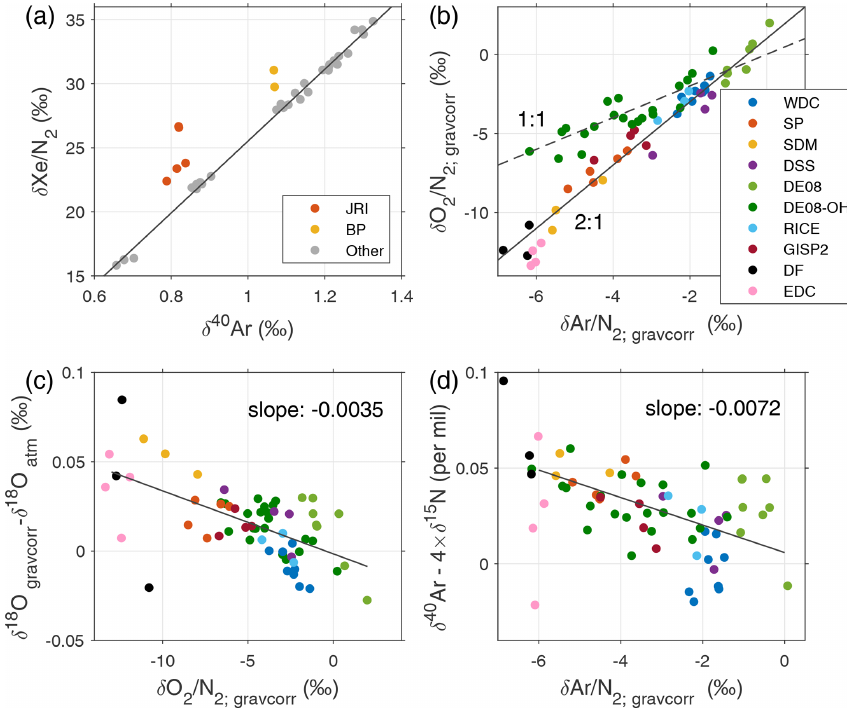
Figure A1. Elemental ratios in the 11-site calibration study of late Holocene samples. (a) δ Xe / N 2 vs. δ 40 Ar in all ice core samples. δ 40 Ar is used solely to illustrate gravitational enrichment, and a similar picture arises when plotted against any isotopic pair. Refrozen meltwater (elevated δ Xe / N 2 ) was seen in all samples from the Antarctic Peninsula (James Ross Island and Bruce Plateau sites), despite selecting samples free of visible melt features. (b) The relationship between the commonly used gas loss proxies δ O 2 / N 2 and δ Ar / N 2 corrected for gravity. (c) Enrichment in δ 18 O (corrected for gravity and atmospheric δ 18 O atm ) plotted against gravity-corrected δ O 2 / N 2 . (d) δ 40 Ar enrichment plotted against gravity-corrected δ Ar / N 2 . In all panels gravitational correction is applied by subtracting δ 15 N times the atomic mass unit